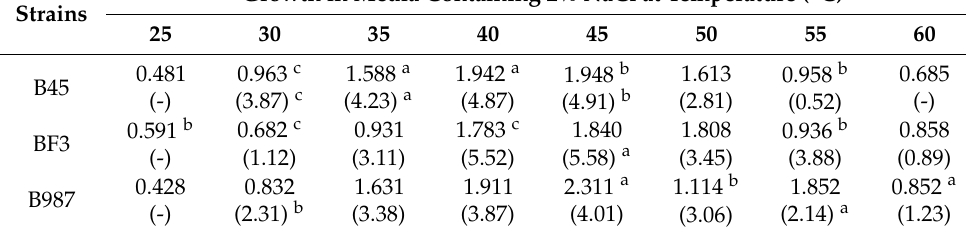
Table 4. Growth of Bacillus thuringiensis B45, B. velezensis BF3 and B. amyloliquefaciens B987 at various temperatures in presence of NaCl. Inoculum maintained at 0.3 OD 600 (corresponded to 2.8–3.2 × 10 8 cells per mL) was transferred, and the final OD was noted after 24 h of cultivation. The OD 600 was taken as reflection of the growth. Endoglucanase, xylanase and pectinase from the strain B45, BF3 and B987 were assayed, respectively. The enzyme titres (IU mL − 1 ) are given in the